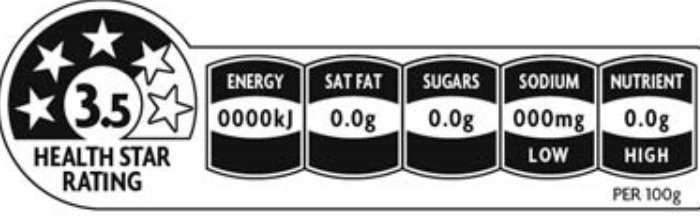
Figure 1. Example of the Health Star Rating front-of-pack logo.